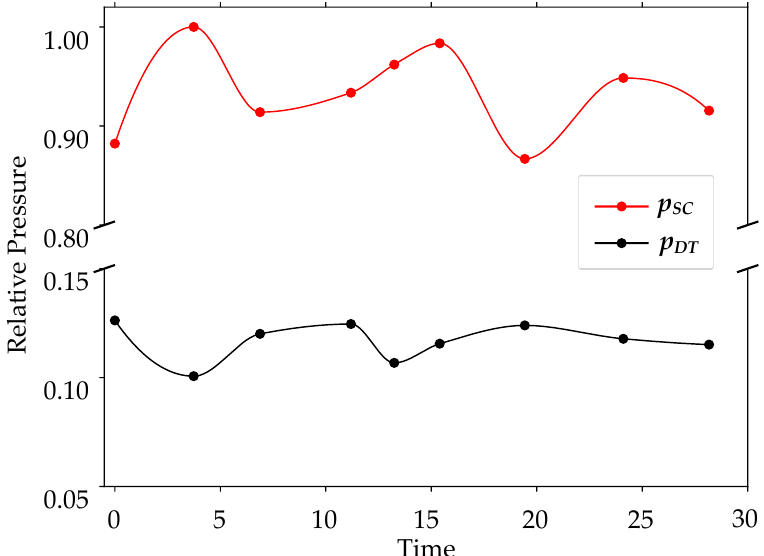
Figure 3. Normalized pressure at the spiral casing inlet and draft tube